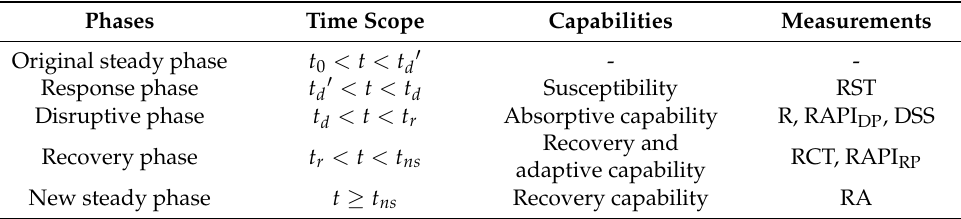
Table 1. Summary of different resilience